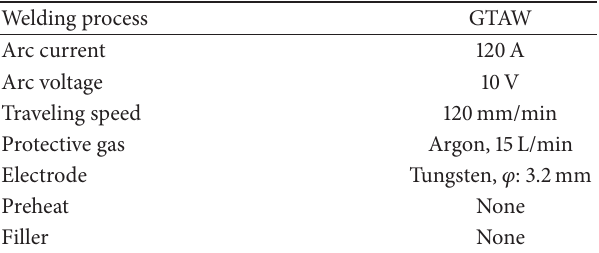
Table 1: Chemical composition of the AISI 304 stainless steel. Element Cr Ni Mn Mo Co Cu Si C Fe wt.% Table 2: The welding parameters of the simultaneous vibration welding.